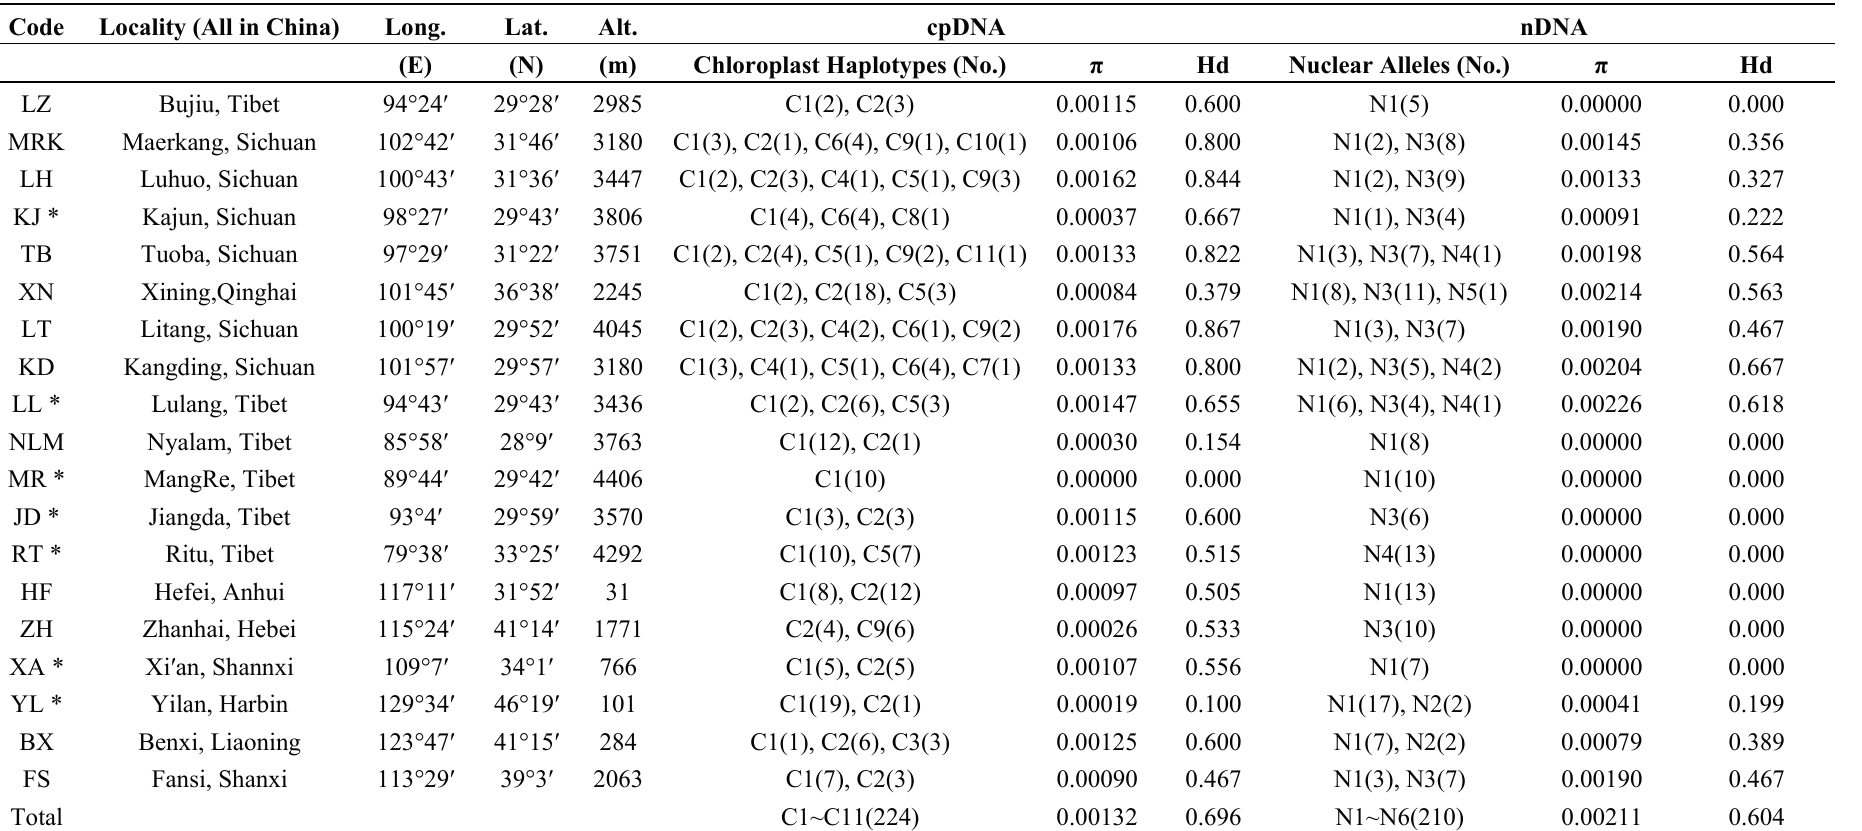
Table 1. Sampling information, haplotypes and frequencies, nucleotide diversity ( π ) and haplotype diversity (Hd) of 19 Thlaspi arvense populations.